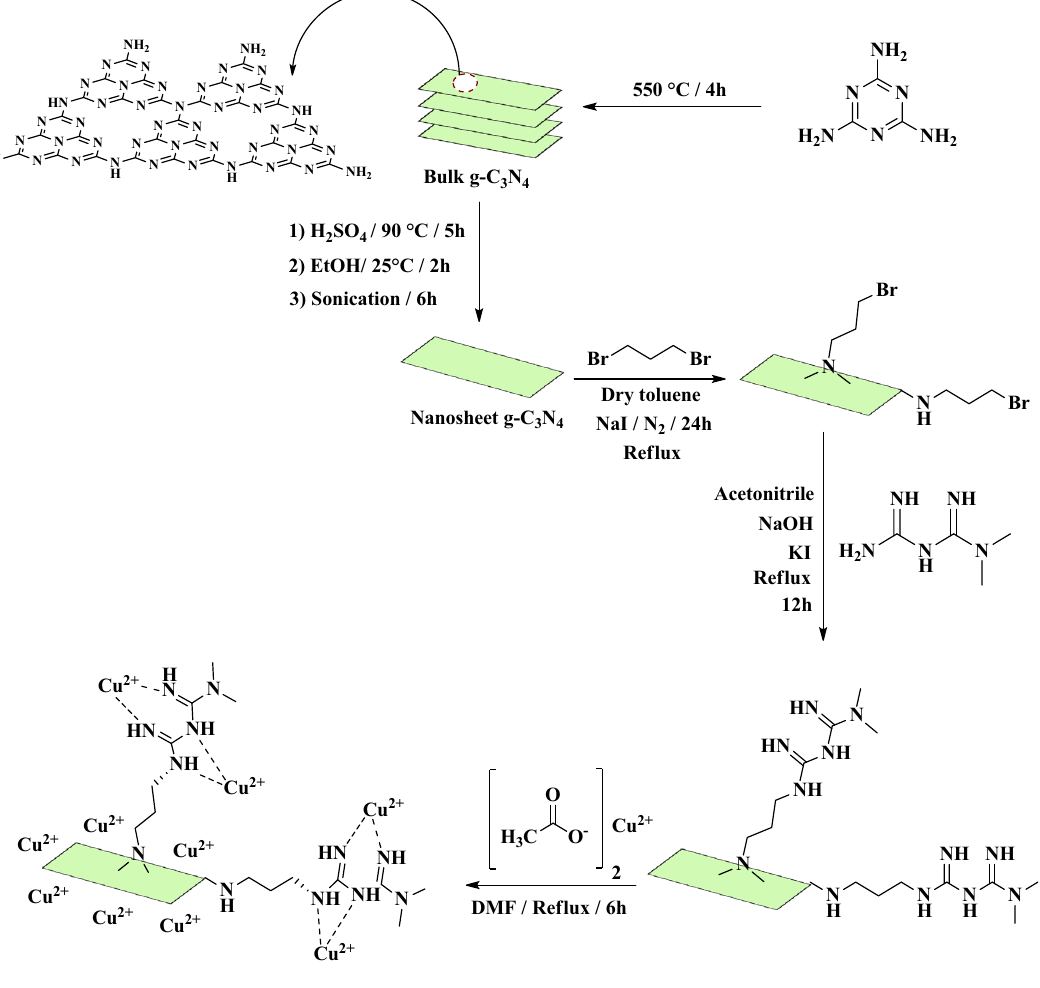
Figure 1. Graphical illustration of CN–Pr–Met–Cu(II) catalyst